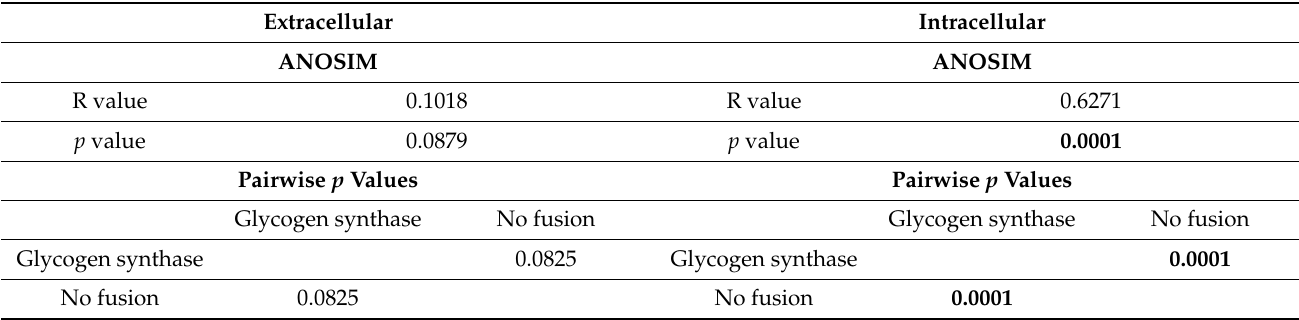
Table 6. A summary of ANOSIM (clustering) test data for the extra- and intracellular faces of the orexin receptors, to support Figure 5; 9999 permutations performed on PC1-5, significant p values (<0.05) are shown in bold.